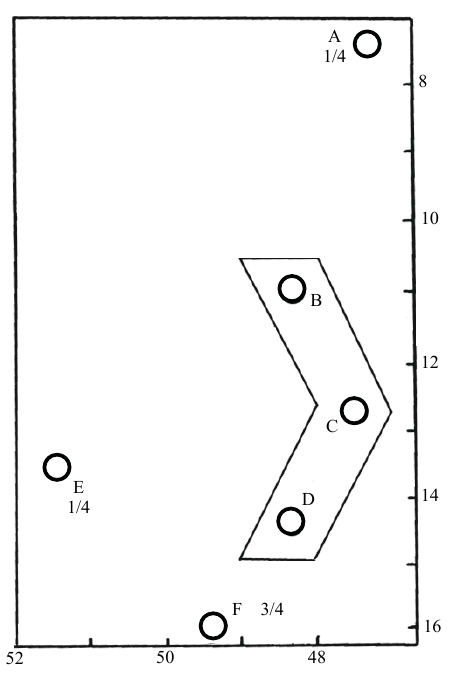
Graph1– Gymnodactyluscarvalhoi. Skeletonmap,inter-sample differences in meristic